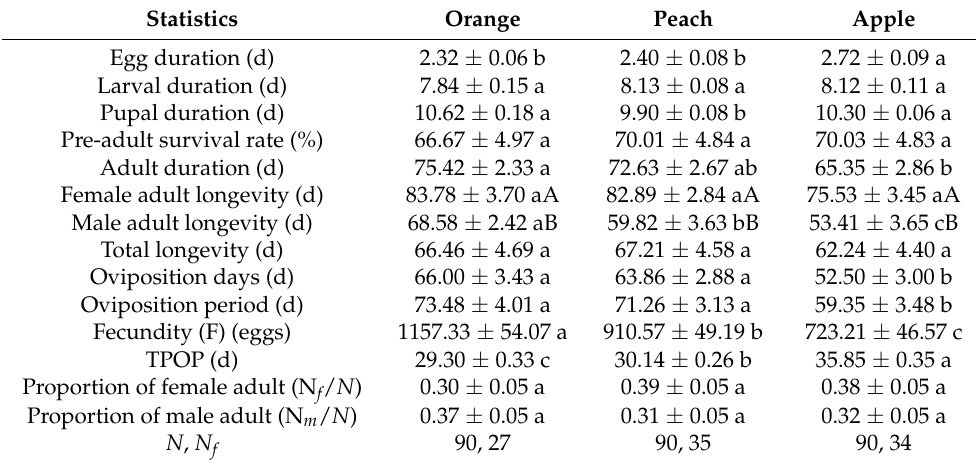
Table 2. Means and standard errors of the developmental durations, pre-adult survival rate, longevity, fecundity, TPOP, female proportion in cohort ( N f / N ), and male proportion in cohort ( N m / N ) of Bactrocera dorsalis on three host